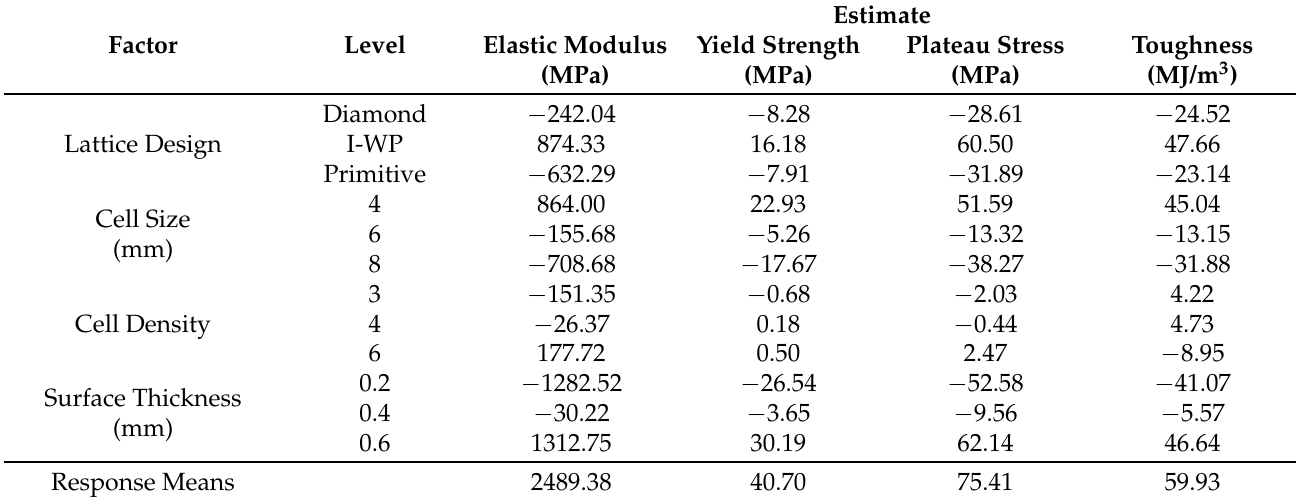
Table 12. Least squares main factor contrasts based on reduced interaction model.